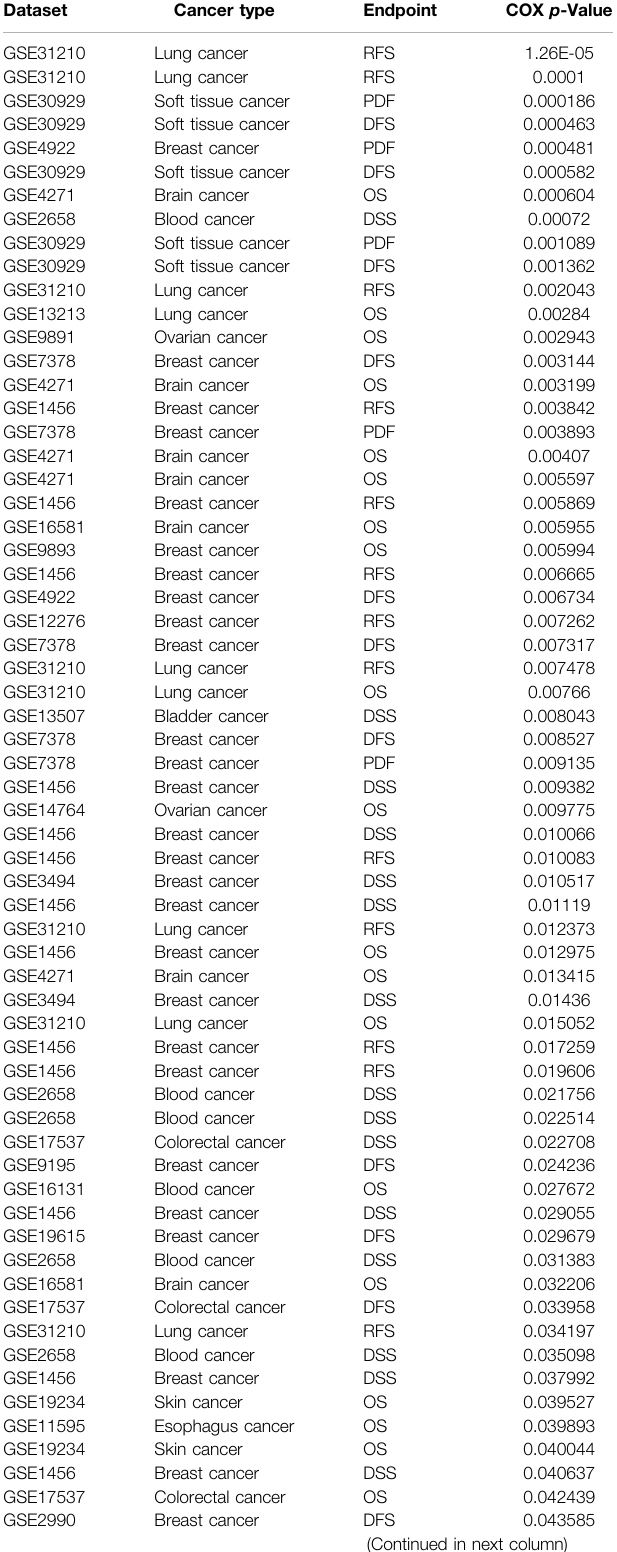
TABLE 4 | The prognosis of IQGAP3 in pan-cancer analysis by using the prognostic database. Dataset